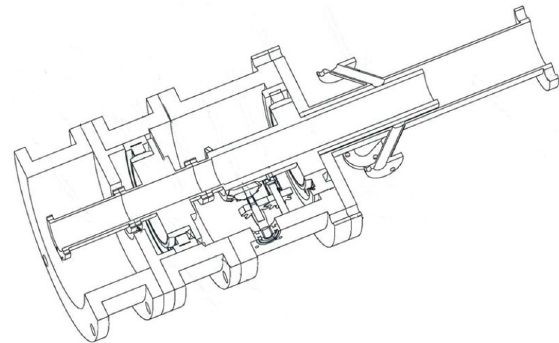
Figure 16. The internal structure of the pulsating wave annular fl ow generator [58].